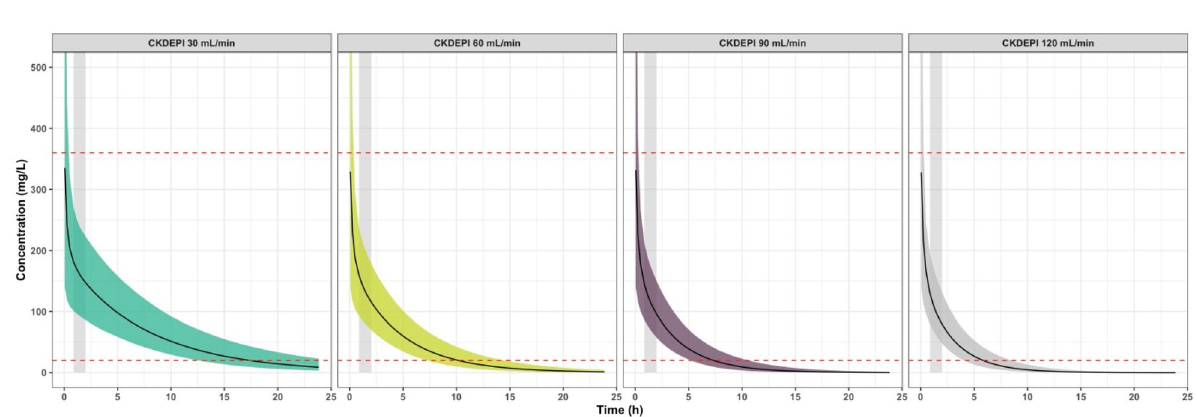
Figure 3. Goodness of fit plots. The black line represents the identity line. NPDE, normalized prediction distribution errors.